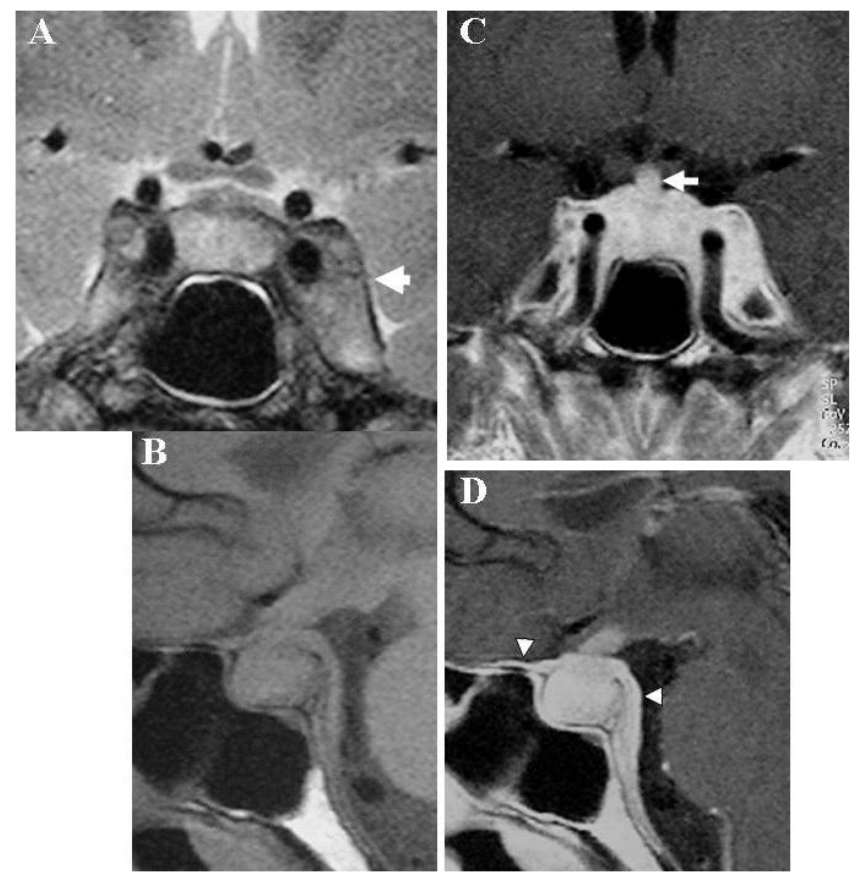
FIGURE 2 . (A) Coronal FSE T2-weighted image MRI demonstrating mild increase of intracavernous pathological tissue (arrow). (B) Sagittal FSE T1-weighted image MRI showing cancellation of normal high signal of the posterior lobe of hypophysis. The neurohypophysis is normally hyperintense on T1- weighted images because of phospholipidic components of oxytocin and vasopressin. (C) Coronal FSE T1-weighted image after Gd-DTPA administration MRI shows persistence of infundibular stalk thickening (arrow). (D) Sagittal FSE T1-weighted image after Gd-DTPA administration MRI demonstrates a persistent thickening of the dura at clivus and at sphenoidal plane (arrow